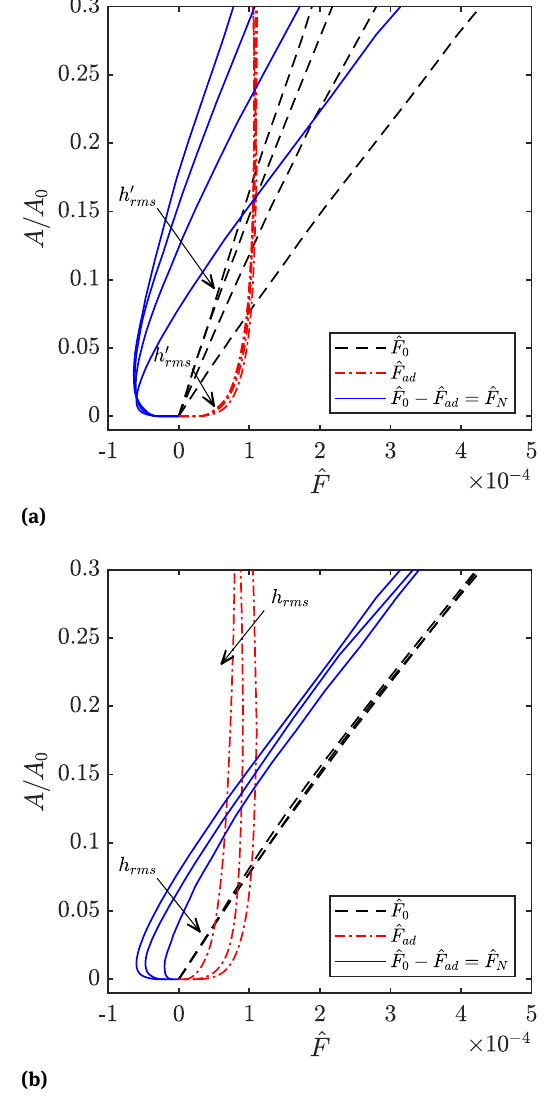
Figure 1: The relative contact area A / A 0 as a function of the dimen- sionless applied pressures ˆ F (blue solid line), ˆ F (black dashed 0 N line), and ˆ F (red dot-dashed lines) for (a) h and rms = 0.52 nm ad different values of h (cid:48) ; (b) rms = 0.0011, 0.0014, 0.0016, 0.0026 h (cid:48) rms = 0.0026 and different h rms = 0.52 nm, 0.68 nm, 1.17 nm .